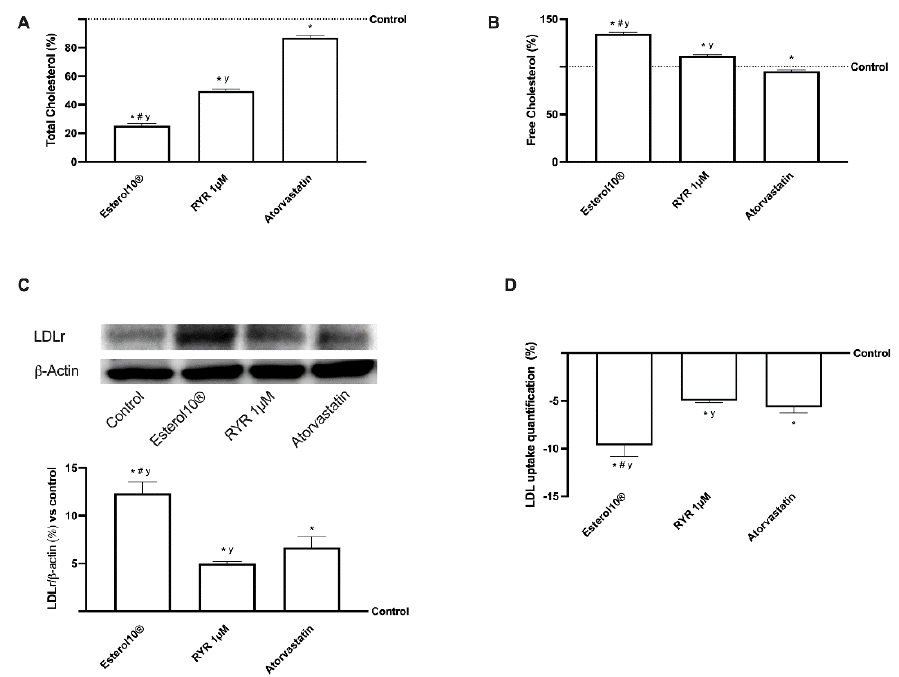
Figure 3. Total Cholesterol ( A ), Free Cholesterol ( B ), LDLr ( C ), and LDL uptake quantification ( D ) on HepG2 cells. The abbreviations are the same reported in Figure 1. Data are mean ± SD of five independent experiments performed in triplicate. In ( C ), the images reported are an example of a Western blot obtained with technical replicates. * p < 0.05 vs. control; # p < 0.05 vs. RYR; y p < 0.05 vs. Atorvastatin.